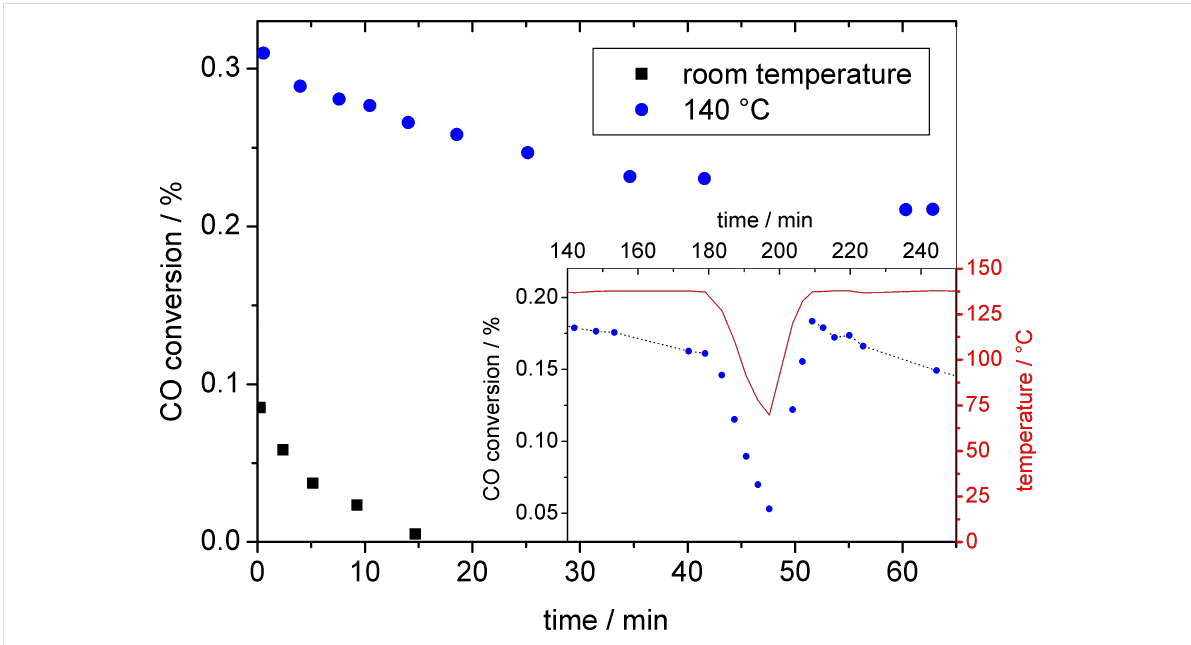
Figure 7: CO conversion during CO oxidation over a mesoporous Au/TiO 2 film as a function of time and sample temperature, at room temperature and at 140 °C. The inset shows the further development of the CO conversion at 140 °C (blue dots) up to 3 h (180 min) under identical conditions and the effect of subsequently modifying the temperature (red curve). Dotted lines serve as guides for